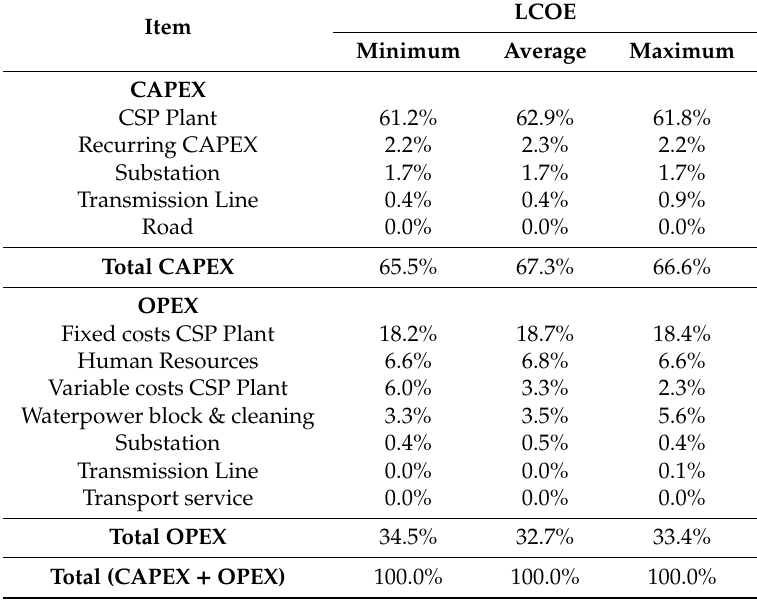
Table 6. DistributionoftheinvestmentcostCAPEXandtheoperationalOPEXforthethreeLCOEscenarios.